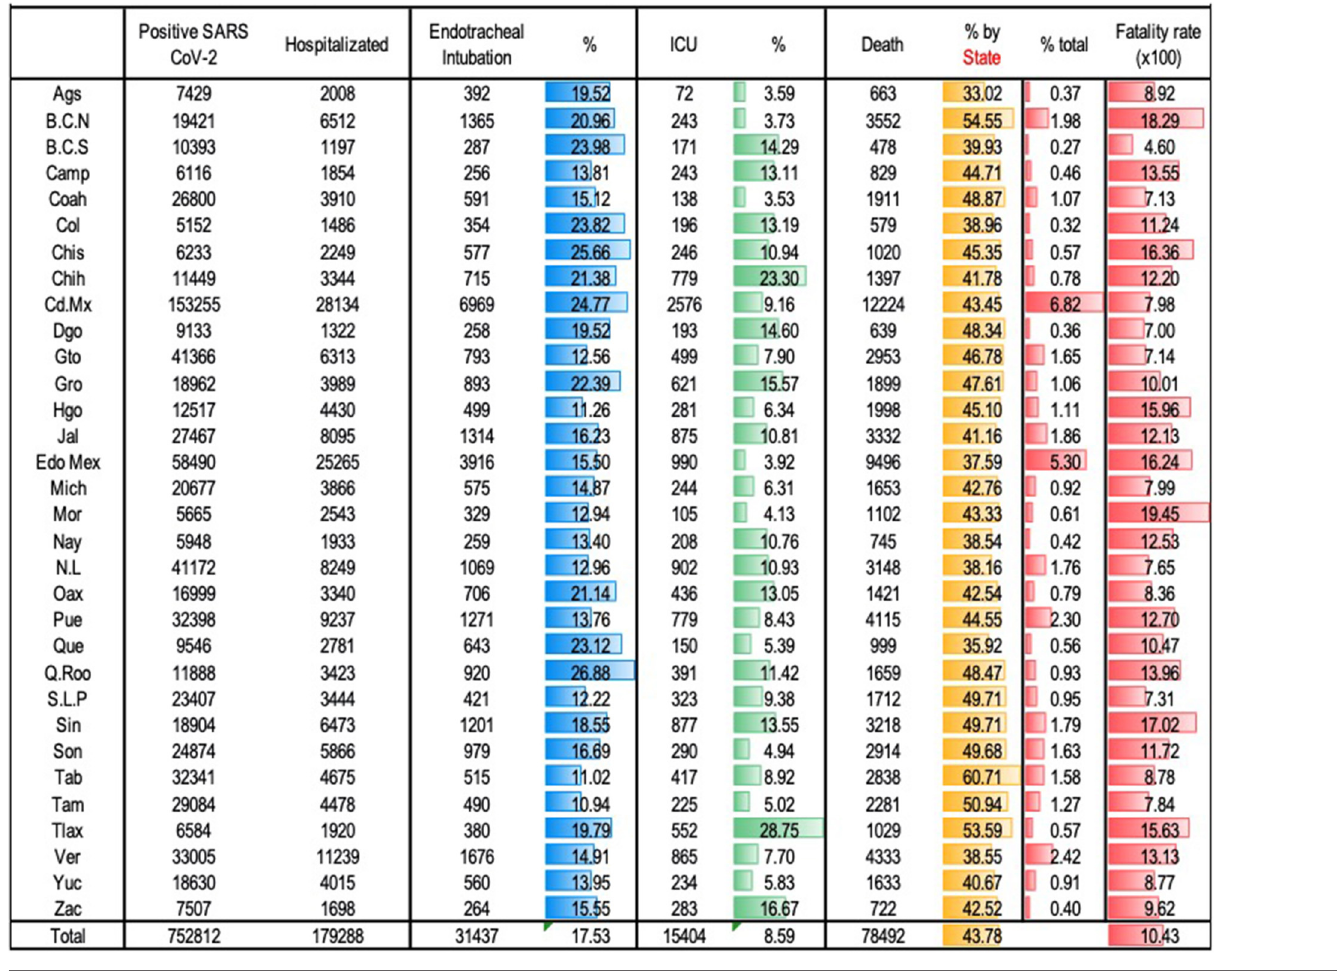
Ags, Aguascalientes; B.C.N, Baja California Norte; B.C.S, Baja California Sur; Camp, Campeche; Coah, Coahuila; Col, Colima; Chis, Chiapas; Chih, Chihuahua; Cd.Mx, Ciudad de México; Dgo, Durango; Gto, Guanajuato; Hgo, Hidalgo; Jal, Jalisco; Edo Mex, Estado de México; Mich, Michoacán; Mor, Morelos; Nay, Nayarit; N.L, Nuevo León; Oax, Oaxaca; Pue, Puebla; Que, Querétaro; Q.Roo, Quintana Roo; S.L.P, San Luis Potosí; Sin, Sinaloa; Son, Sonora; Tab, Tabasco; Tam, Tamaulipas; Tlax, Tlaxcala; Ver, Veracruz; Yuc, Yucatán; Zac,